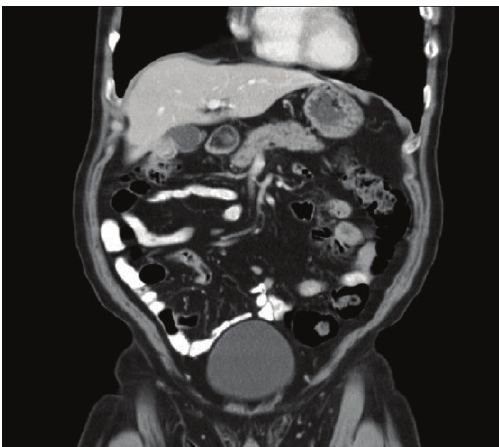
Figure 2: CT scan showing ovoid mass in